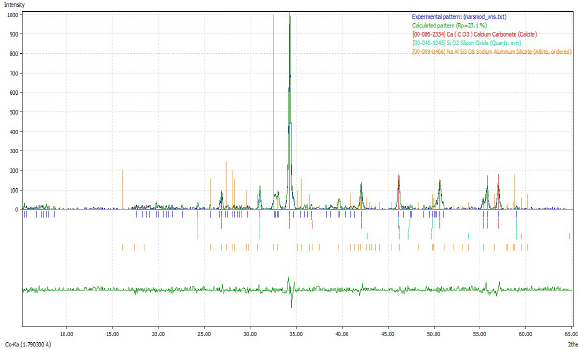
Fig. 4. Most of the minerals determined in pine wood ash by XRD analysis